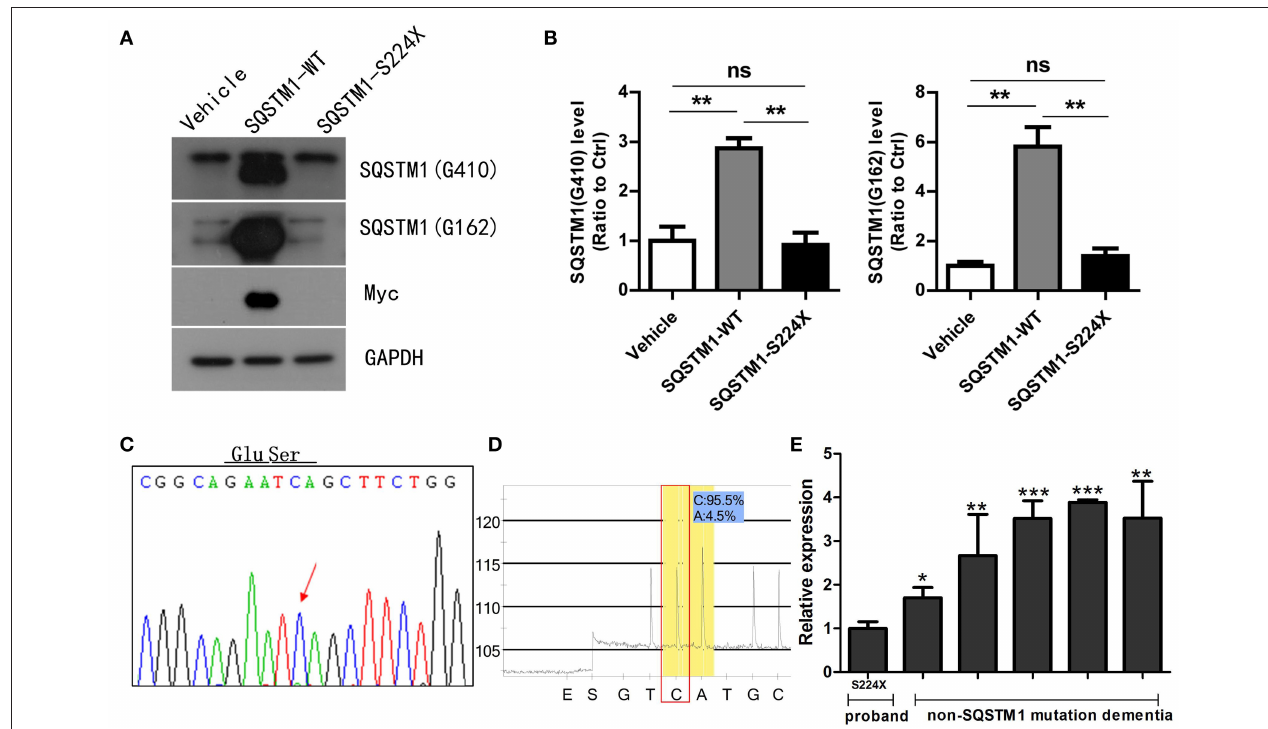
FIGURE 3 | Mutant SQSTM1 protein and cDNA levels. (A) HEK 293T cells were transfected with an empty vector or plasmids encoding either wild type or mutant Myc-His-tagged SQSTM1 (S224X) for 24h. Intact and truncated SQSTM1 proteins were recognized by western blotting with SQSTM1 (G410) and SQSTM1 (G162) antibodies, respectively. (B) The protein levels of SQSTM1 were quantified by densitometry and expressed as ratios to GAPDH. There were significantly reduced levels of intact or truncated SQSTM1 proteins in the S224X mutation group compared to wild type, similar to the vehicle. There was no expression of Myc protein in the vehicle or S224X mutation group, only in wild type. Data were plotted as mean ± SEM ( n = 3). ** p < 0.01, One-way ANOVA. (C,D) SQSTM1 cDNA from peripheral blood leucocytes of the patient was analyzed by Sanger sequencing and pyrosequencing. The mutation was not detected in SQSTM1 cDNA through Sanger sequencing, and only 4% of mutation was detected through pyrosequencing. The arrow indicates the mutant site. (E) SQSTM1 gene expression, measured by quantitative real-time PCR, normalized to β -actin, in peripheral blood leucocytes from the patient and five dementia controls without SQSTM1 mutation. The expression of SQSTM1 mRNA from the patient was significantly reduced compared to controls. Data were plotted as mean ± SEM ( n = 3). * p < 0.05; ** p < 0.01; *** p < 0.001, one-way